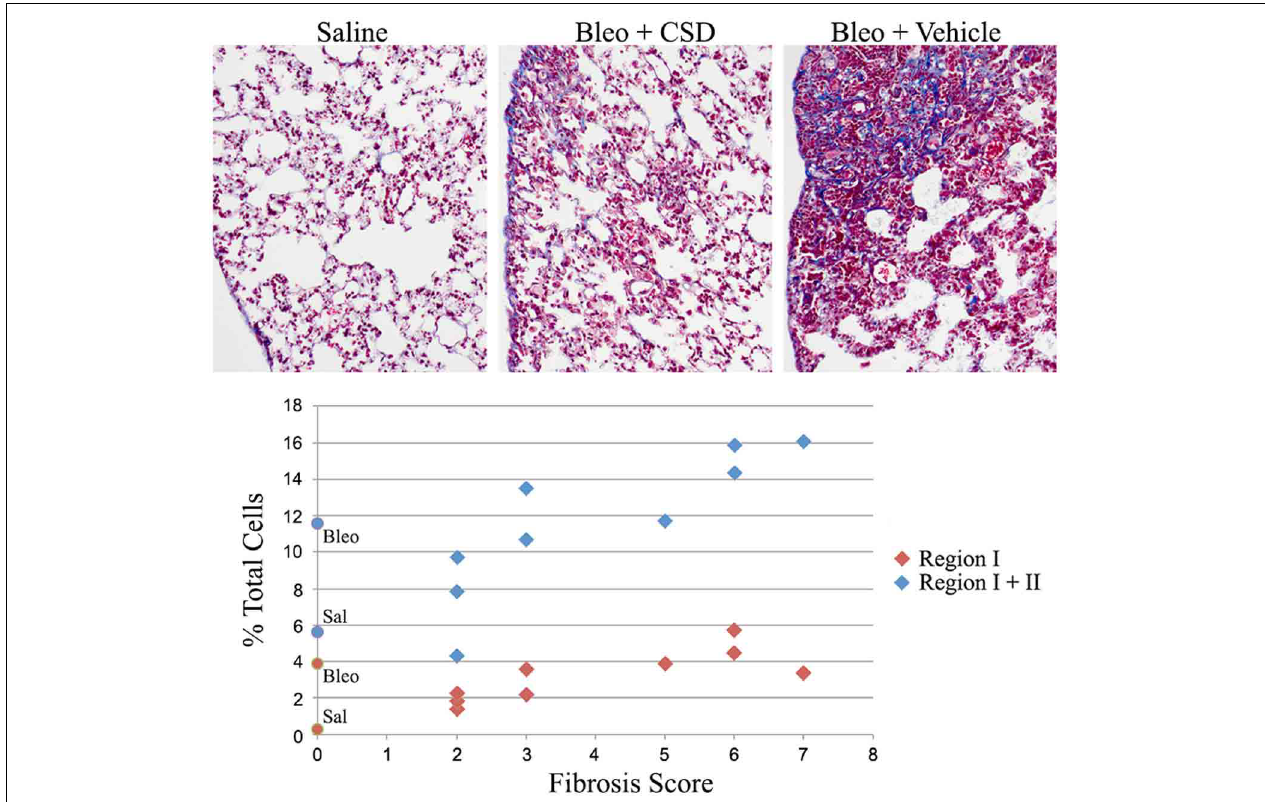
FIGURE 10 | Correlation between fibrocyte number and fibrosis score. Mice were treated with saline or bleomycin followed 12 days later by treatment with CSD or vehicle for 2 weeks. Mice were then sacrificed on day 26 for histological evaluation and quantification of cells in Regions I and II. Top: Images are shown for mice treated with Saline (Fibrosis Score 0), Bleomycin + CSD (Fibrosis Score 2 to 3, 5 of 9 mice responded in this manner), and Bleomycin + Vehicle (Fibrosis Score 5 to